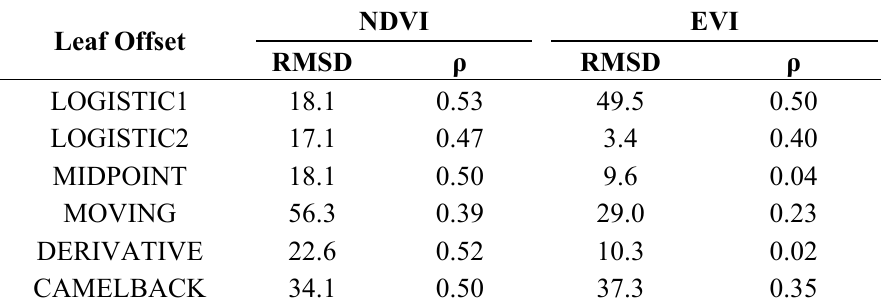
Table 6. Performance of modeled